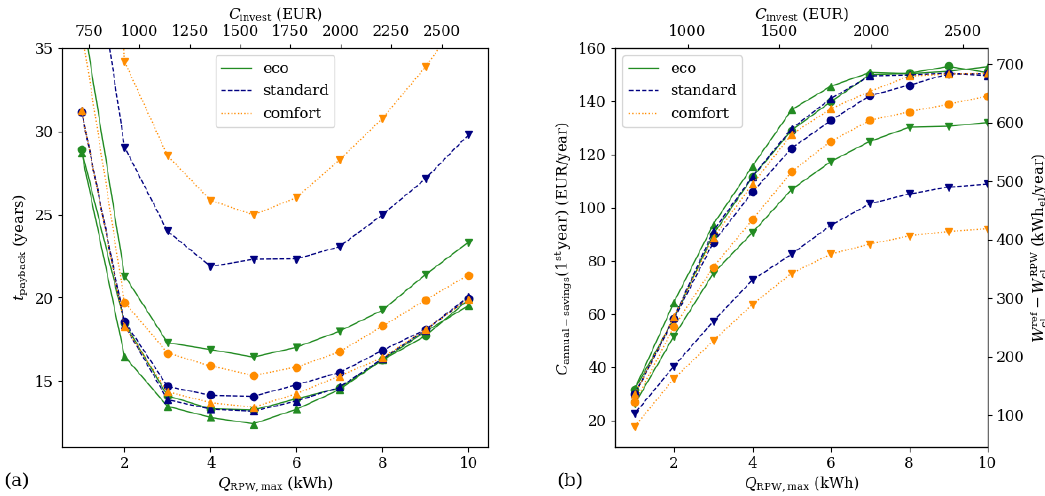
Figure 2. Payback time ( a ) and savings per year ( b ) for Case #1 (passive house located in Helsinki). Markers “ ▼ ”, “●” and “ ▲ ” denote small (140 L), medium (210 L) and large (280 L) decentralized DHW storage devices.